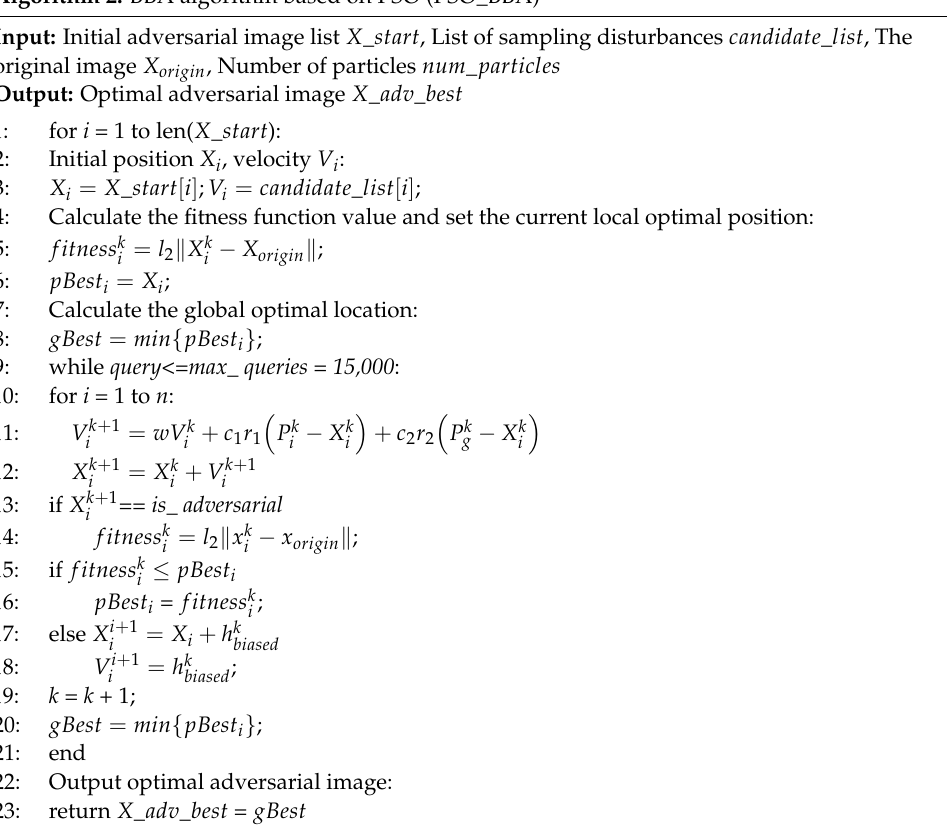
Algorithm 2. BBA algorithm based on PSO (PSO_BBA)